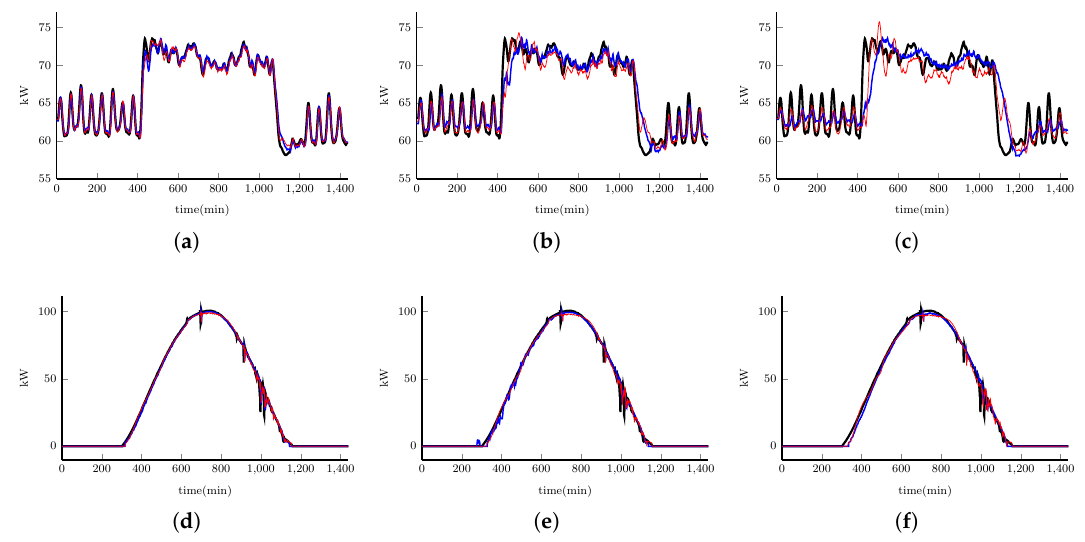
Figure 8. Results from 5 June 2015 for the ARMA model and the neural network model with a ( a ) 5-, ( b ) 10- and ( c ) 15-sample prediction horizon for the CIESOL building; and with a ( d ) 5-, ( e ) 10- and ( f ) 15-sample prediction horizon for the PV system. ( ) Measured, ( ) ARMA model, ( ) NN model.